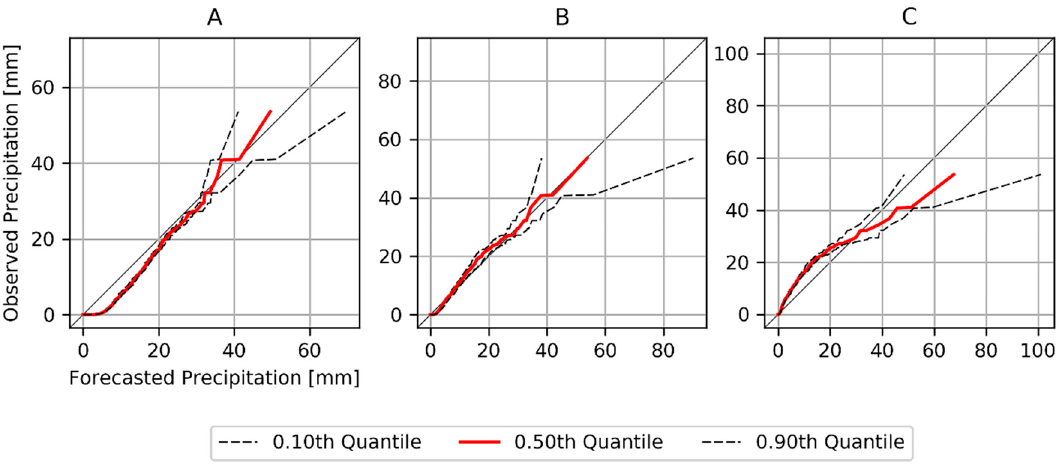
Figure 4. Quantile–quantile plot for grid point ( A ; 7.37 ◦ N, 0.00 ◦ E), ( B ; 10.18 ◦ N, 0.00 ◦ E) and ( C ; 12.98 ◦ N, 0.00 ◦ W) for 15 SYS4 ensembles (initialized in February) versus CHIRPS observations. The plots are based on daily precipitation amounts (mm) for the investigation period (1 February to 31 August, 2000 to 2010).